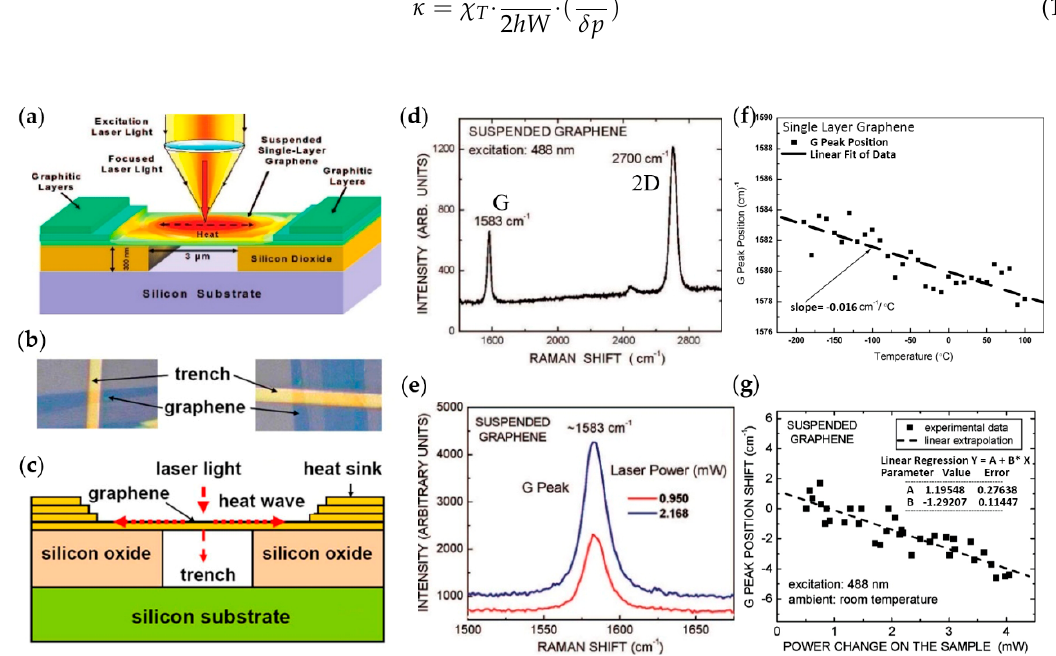
Figure 5. The group diagram for measuring the thermal conductivity of single graphene by micro-Raman spectroscopy. ( a ) Schematic of experiment model for measurement. In this schematic, the focused laser light exposure on a graphene layer suspended across a trench producing a hot spot and being incident light of Raman spectroscopy. The heat sink is graphitic layer to ensure good heat dissipation at the edge of the layer of graphene. Reproduced with permission from [22]. Copyright 2008, American Chemical Society. ( b ) The vertical scanning electron microscopy image of the suspended graphene flakes where one can clearly see the trench and suspended graphene. ( c ) The front view of experiment model. In this schematic, one can more clearly see that a hot spot generates heat waves inside single-layer graphene (SLG) propagating toward heat sinks. In addition, the silicon substrate and the upper silicon oxide are also given for clarity. Reproduced with permission from [125]. Copyright 2008, American Institute of Physics. ( d ) Raman spectrum of suspended graphene showing the G peak (at ~1583 cm − 1 ) and 2D peak (at ~2700 cm − 1 ) at room temperature excited at 488 nm. ( e ) Raman spectrum of G peak at two different laser power. The red and blue lines represent 0.950 and 2.168 mW, respectively. Weakly evolution of Raman shift of G peak occurs in different laser power. ( f ) Temperature dependence of the G peak frequency for the single layer graphene. The solid square black spots are experimental data of G peak position at a certain temperature and the fitted straight dash line slope is the temperature coefficient which is − 0.016 cm − 1 / ◦ C Reproduced with permission from [124]. Copyright 2007, American Chemical Society. ( g ) The G peak position shift dependence of total dissipated laser power excited at 488 nm. The fitted straight dash line slope is the power coefficient. The inserted chart illustrates a method of fitting data using linear regression equations where the values of parameter A and B are given. Reproduced with permission from [22]. Copyright 2008, American Chemical